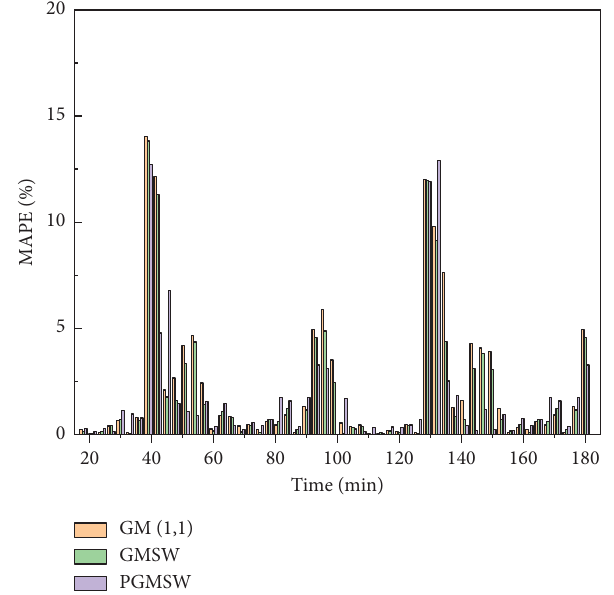
Figure 9: MAPEs of the three models (window size �